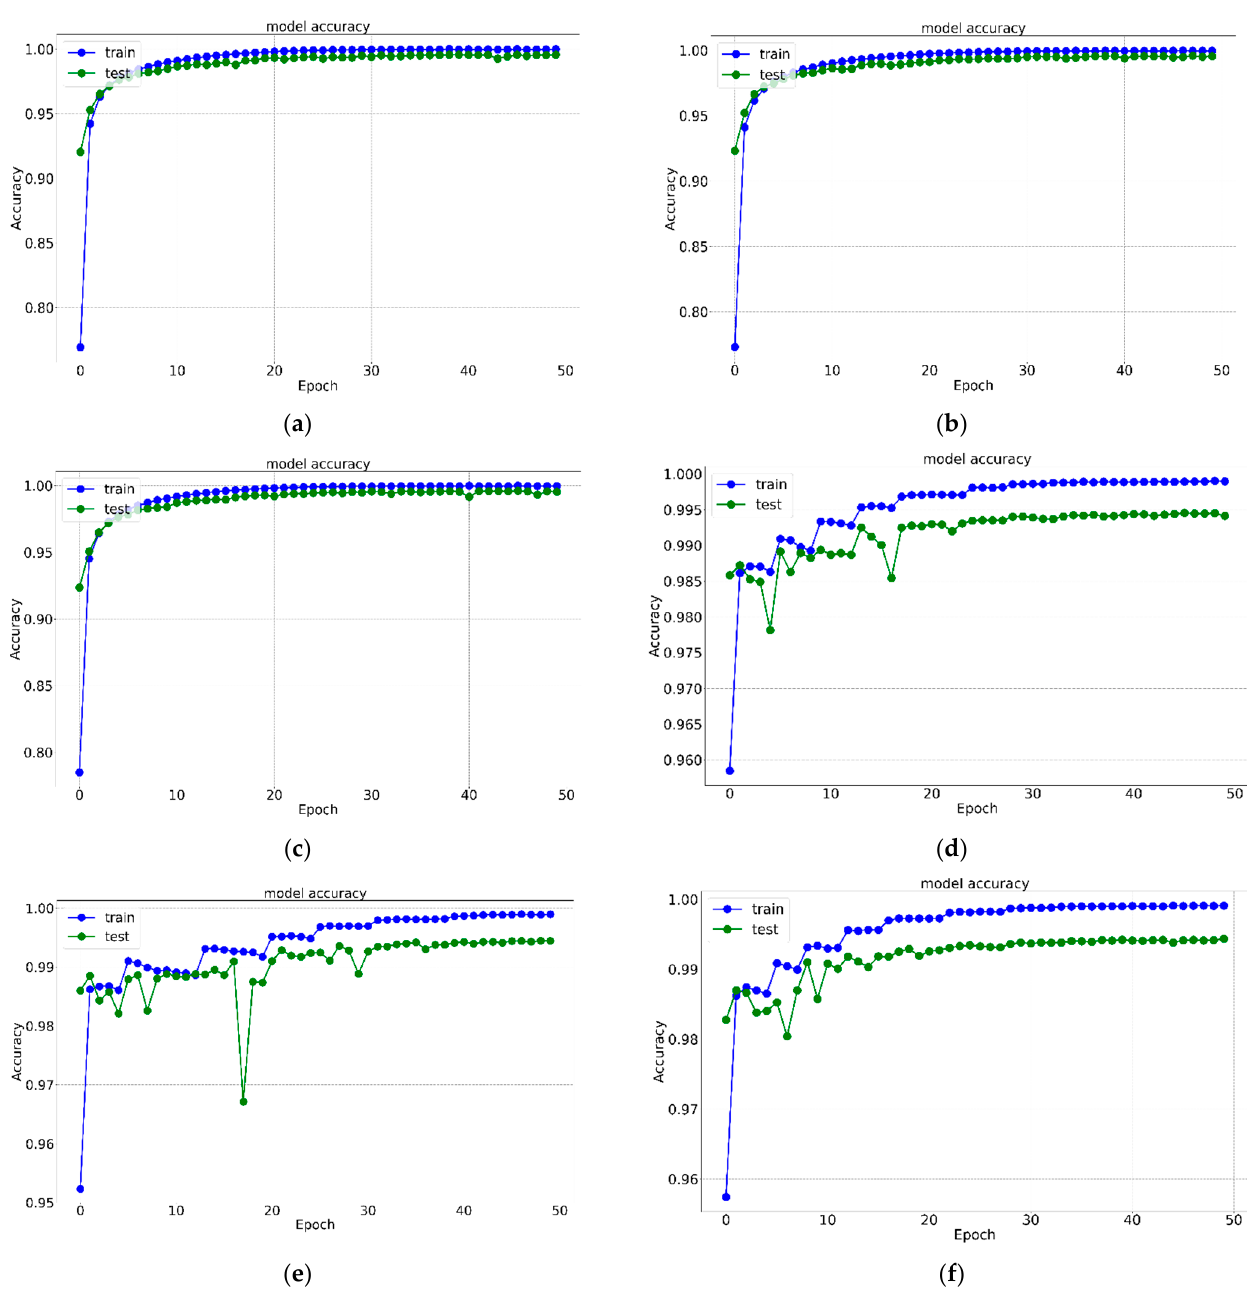
Figure 8. Validation accuracy of the six models for English alphabet recognition. ( a ) Optimizer—‘ADAM’; learning rate—0.001. ( b ) Optimizer—‘ADAM’; learning rate—0.0001. ( c ) Optimizer—‘ADAM’; learning rate—0.00001. ( d ) Optimizer—‘RMSprop’; learning rate—0.001. ( e ) Optimizer—‘RMSprop’; learning rate—0.0001. ( f ) Optimizer—‘RMSprop’; learning rate—0.00001.